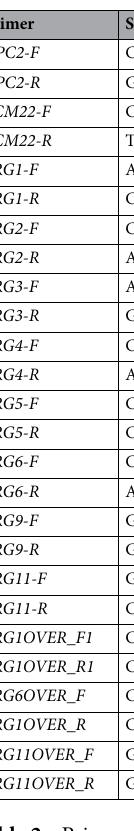
Table 2. Primers used in the real-time RT-PCR and plasmid